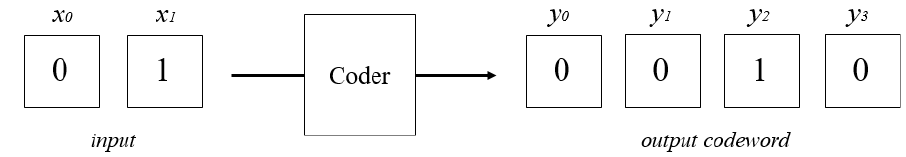
Figure 1. Example of encoder output stream y given the x input sequence 01.